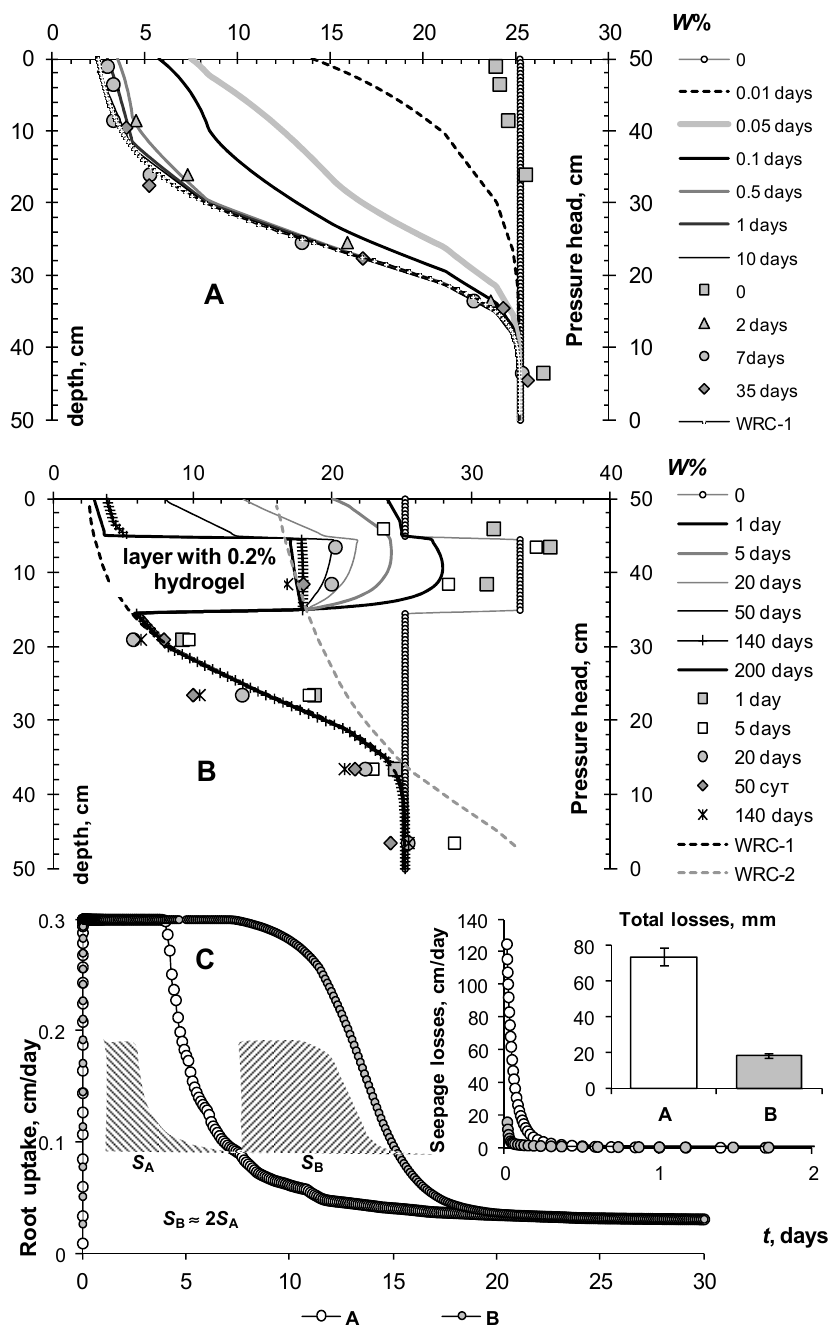
Figure 1. Intelligent soil design using HYDRUS-1D: ( A ) — untreated control; ( B ) — capillary gel barrier; ( C ) — lawn root water uptake (main figure), unproductive water losses (inset); WRC-1,2 — equilibrium water retention according to WRC of the sandy substrate (1) and its composition with 0.2% hydrogel (2). other lines in figures ( A , B ) are the results of water dynamics simulations; symbols are experimental water content data.